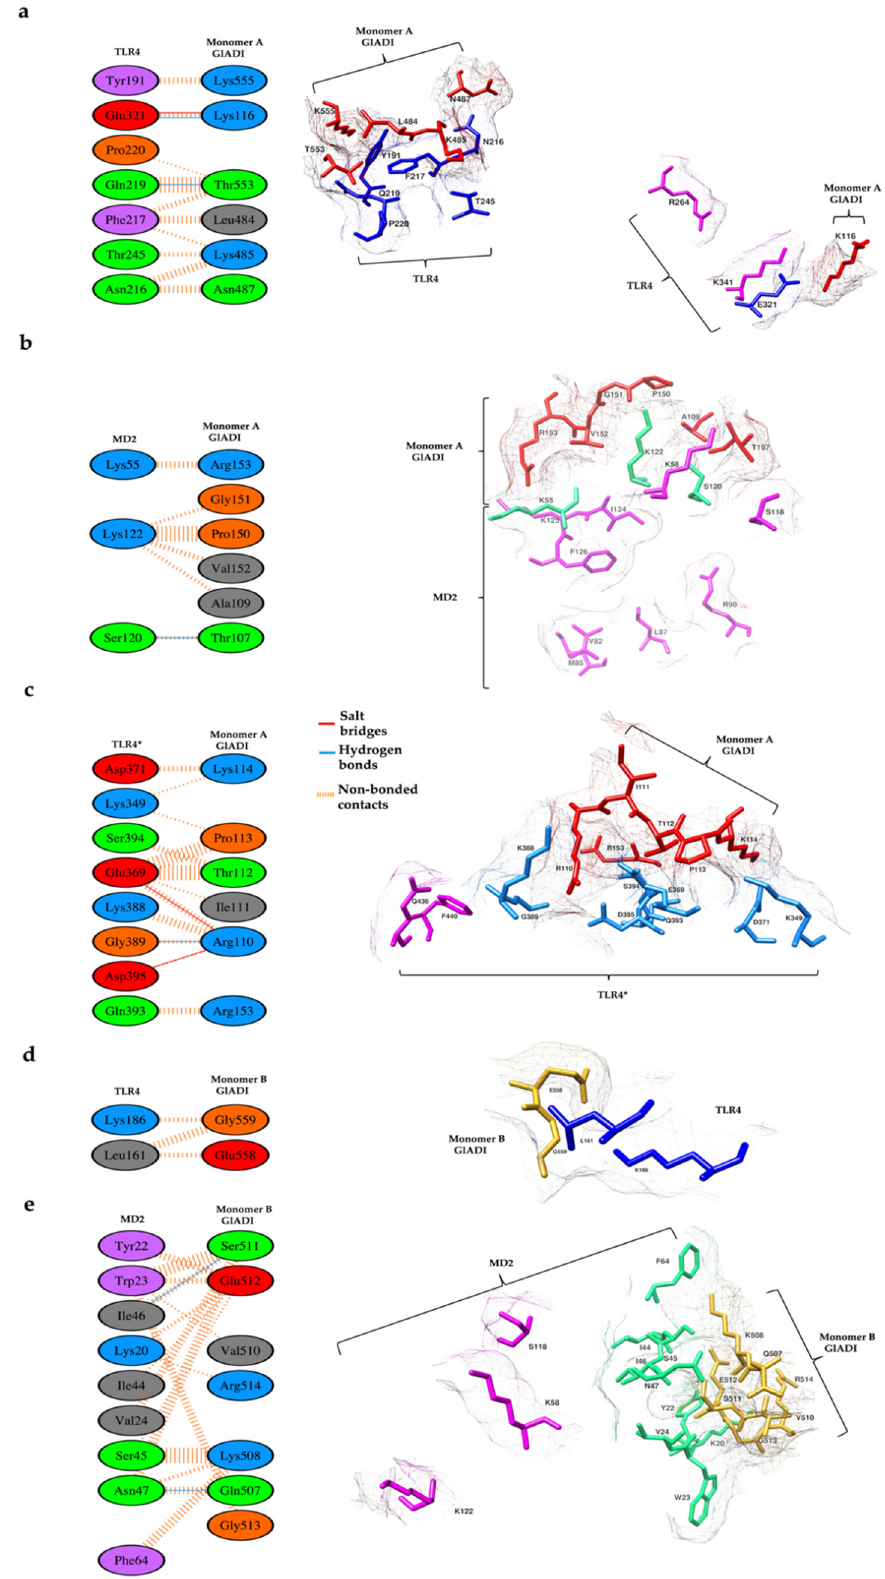
Figure 8. Amino acid residues proposed to interact between AlphaFold-predicted structure of GlADI and the ectodomain of human TLR4 dimer in complex with MD-2. ( a ) Protein–protein inter- action of monomer A of GlADI (red-colored, right side) with TLR4 (blue-colored, right side) and the